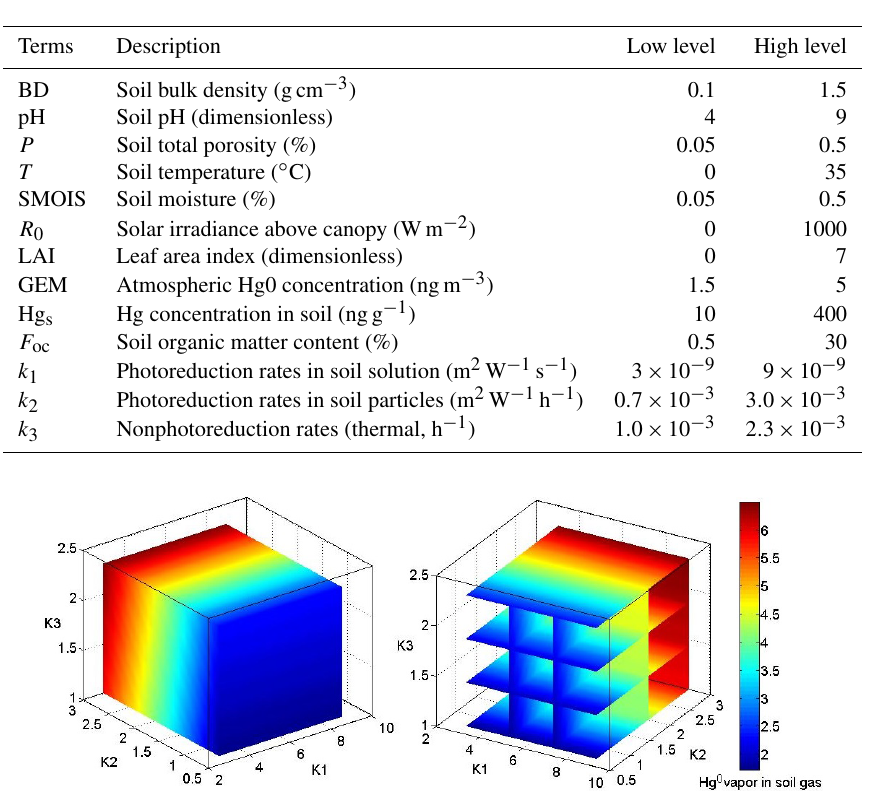
Table 2. Examined model variables and the experimental levels of factorial design for air–soil exchange.